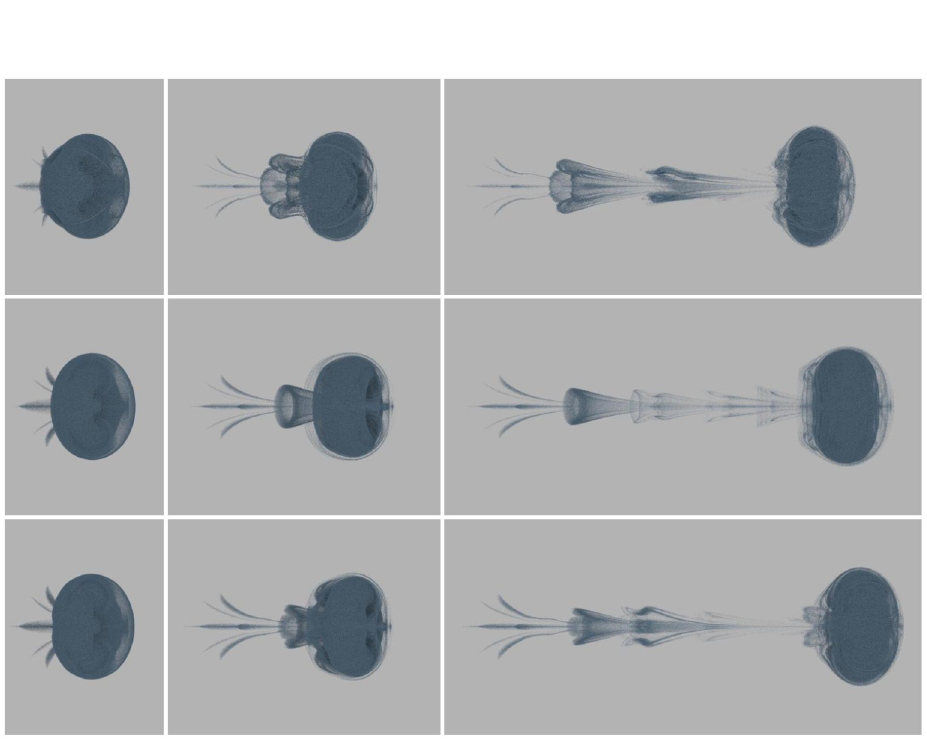
Fig 7. Vortex ring comparison of the octree grid method, the nested grid method and the direct summation method. The first row: the octree grid; the second row: the direct summation; the third row: our nested grid.